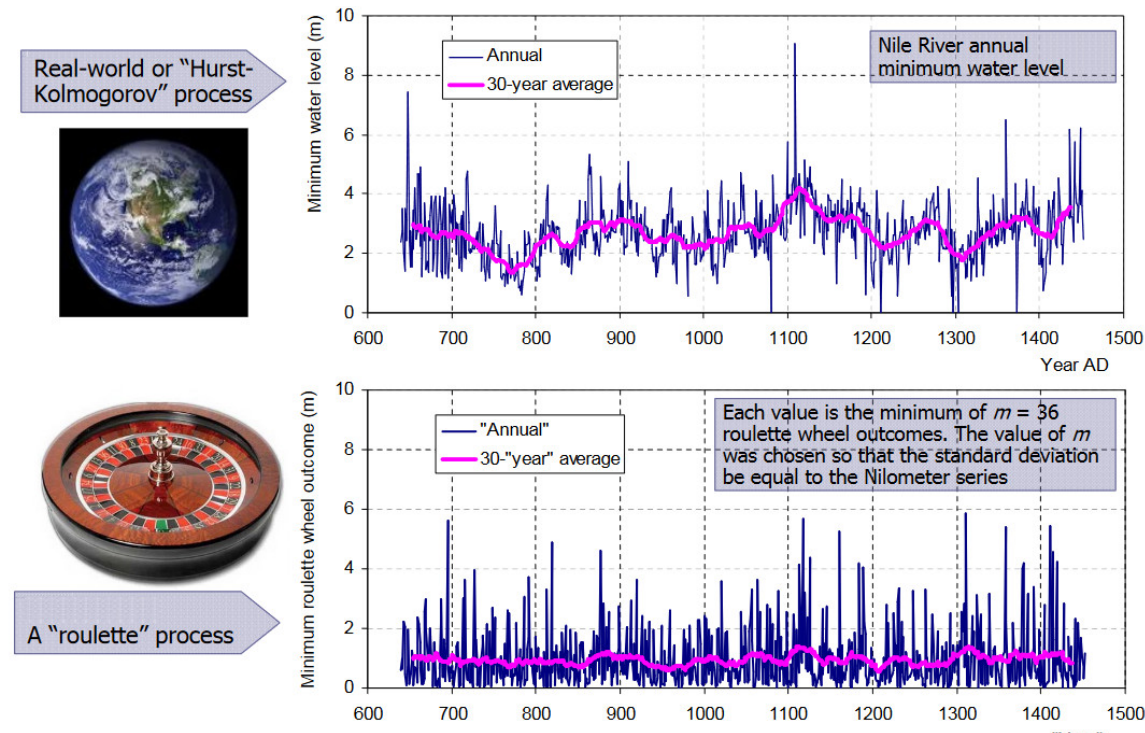
Figure 2. Hurst–Kolmogorov (HK) dynamics present in the annual minimum water level of the Nile River as a result of the perpetual change of Earth’s climate, and as compared to a roulette timeseries resembling a white noise process. Source: [14] (supplementary material).